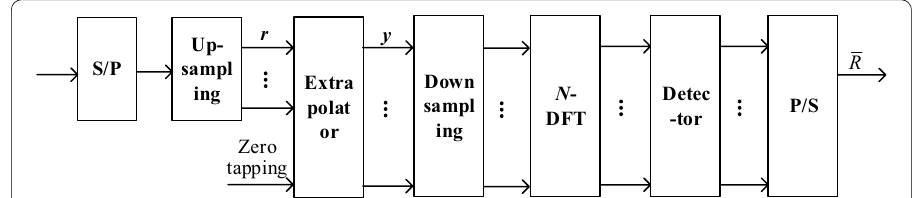
Fig. 2 Simplified recovery modem for compressive OFDM signals